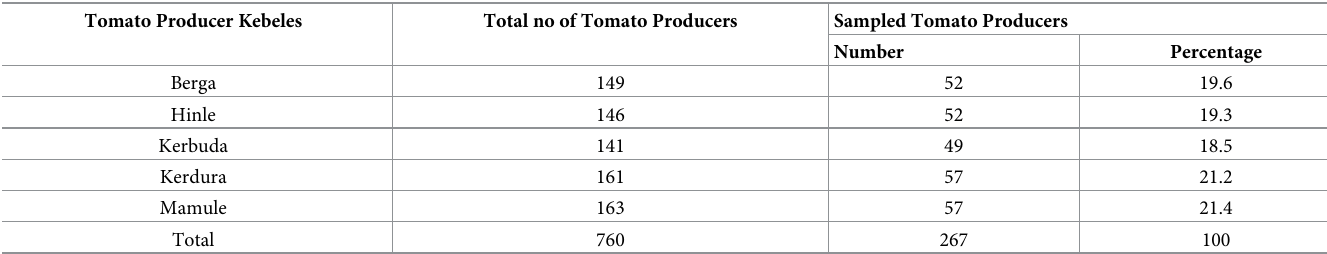
Table 1. Tomato growing farmers and sample